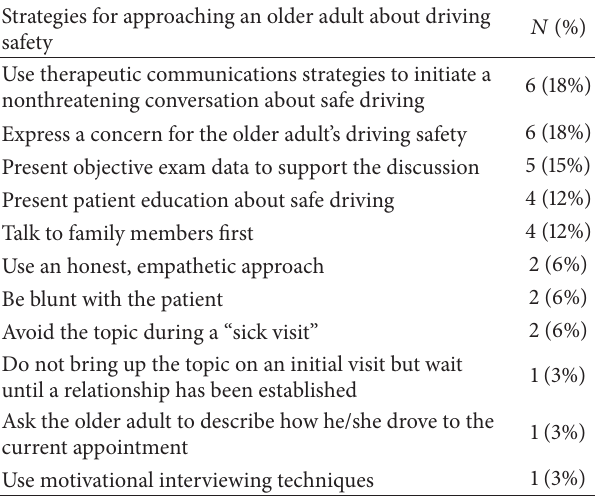
Table2:Whatstrategiesdidyouusetoapproachthetopicofdriving safety with the older adult ( 𝑛 = 34